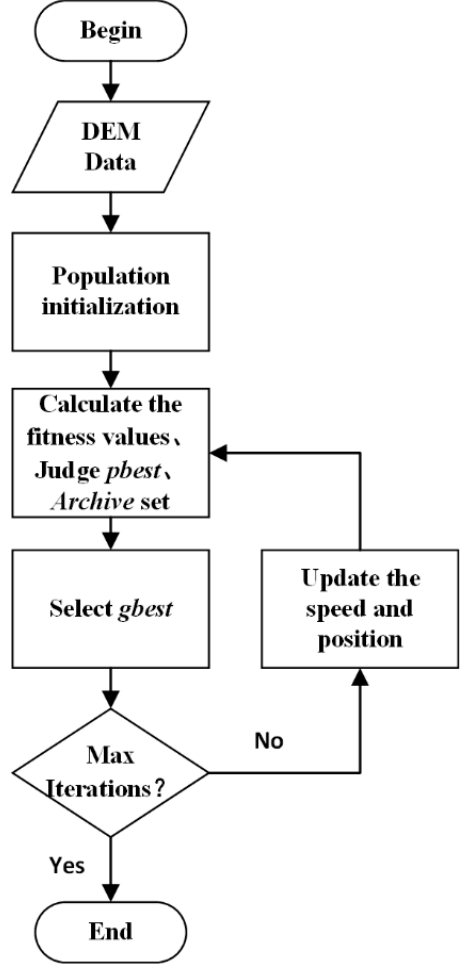
Figure 7. MOPSO flow chart.